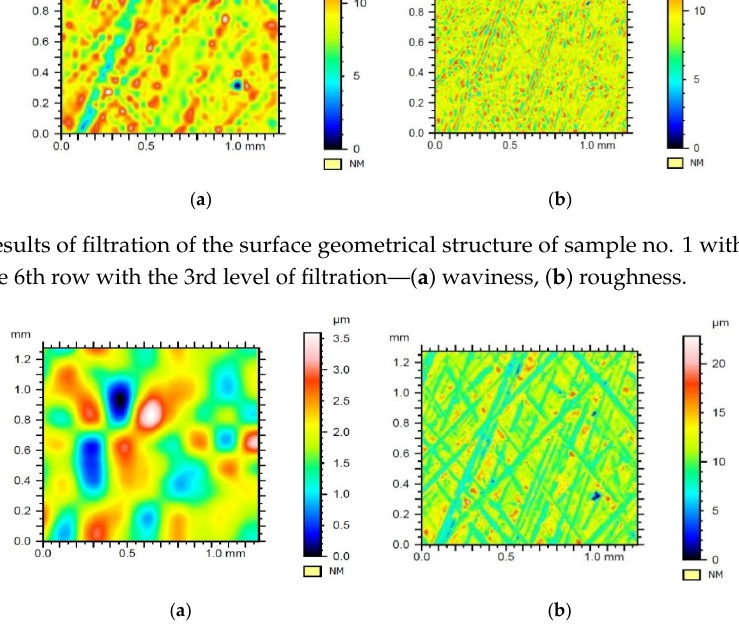
wavelet of the 6th row with the 5th level of filtration—( a ) waviness, ( b ) roughness.